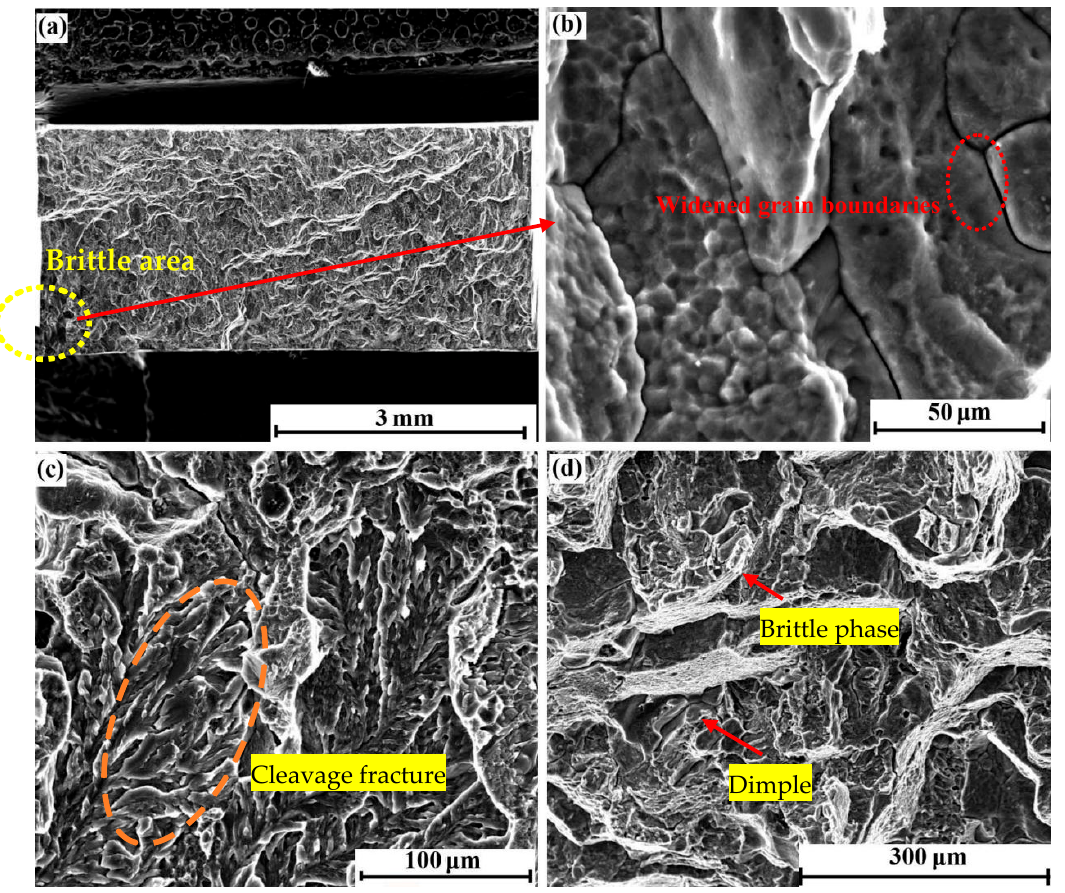
Figure 4. Tensile fracture morphology in simulated working condition: ( a ) The whole morphology, ( b ) The amplification morphology of the brittle area, ( c ) The cleavage fracture area ( d ) The plastic fracture area.